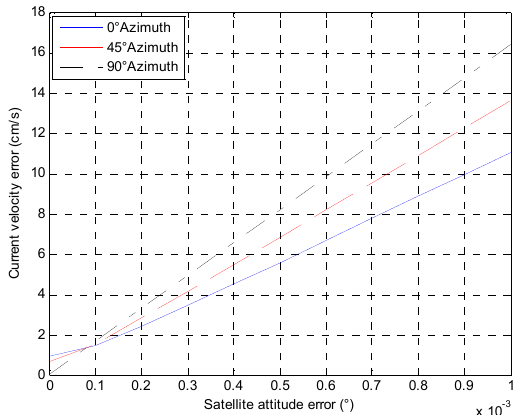
Figure 24. Effects of satellite attitude and velocity determinations on current velocity error.